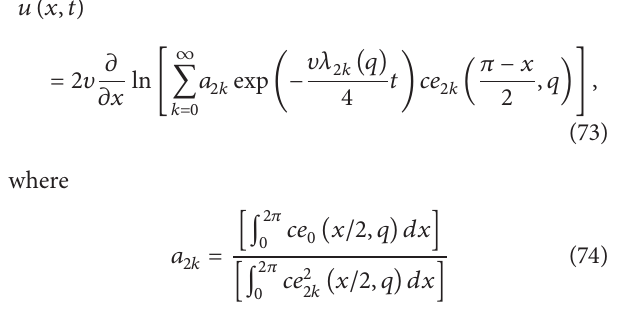
The numerical results compared with the exact solutions for 𝜐 = 1 with 𝑞 = 20 and 𝜐 = 0.1 with 𝑞 = 100 in Tables 8 and 9, respectively. The numerical calculations are performed with Δ𝑡 = 0.001 and 𝑐 = ℎ . The space-time graph of the